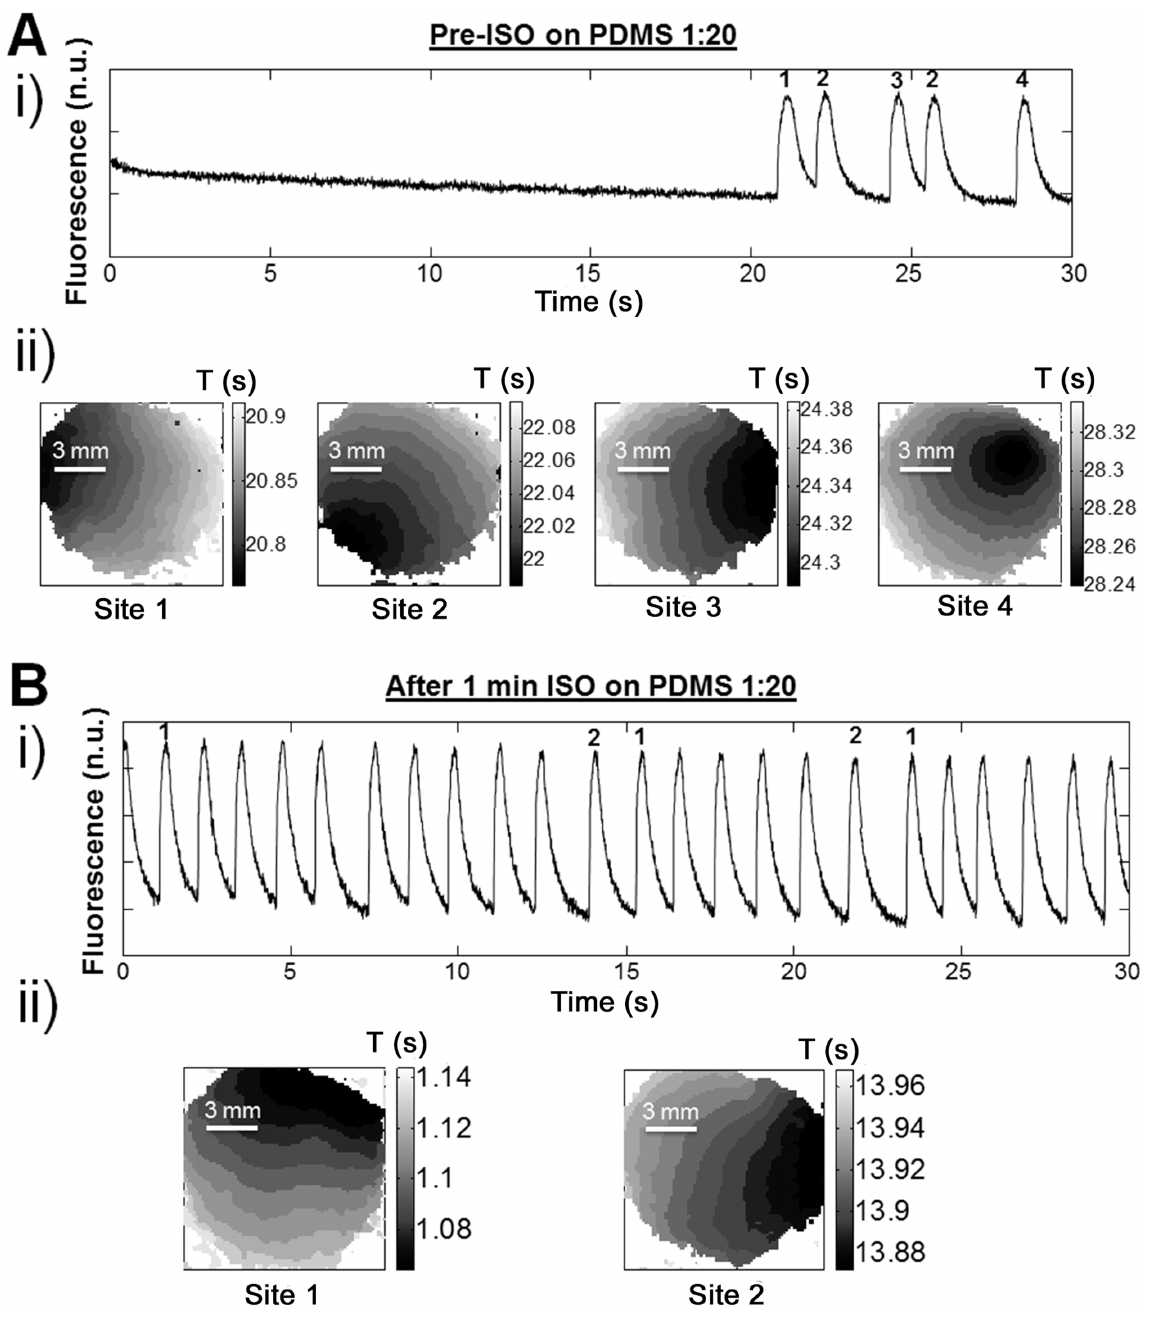
Fig 6. ISO decreases σ period for cardiomyocytes cultivated on PDMS 1:20 and tends to stabilize the rate of contraction. Examples of cardiomyocyte activity stabilization by the addition of isoproterenol. i) A trace of the contractile activity is shown with ii) activation maps of the first beat for each different activation site. A . Conditions before the addition of isoproterenol (Pre-ISO) on PDMS 1:20. B . One minute after adding ISO (100 nM) on PDMS 1:20 substrates. Pharmacological sympathetic stimulation appears to decrease the number of activation sites (from 4 sites pre-ISO to 2 sites after ISO).